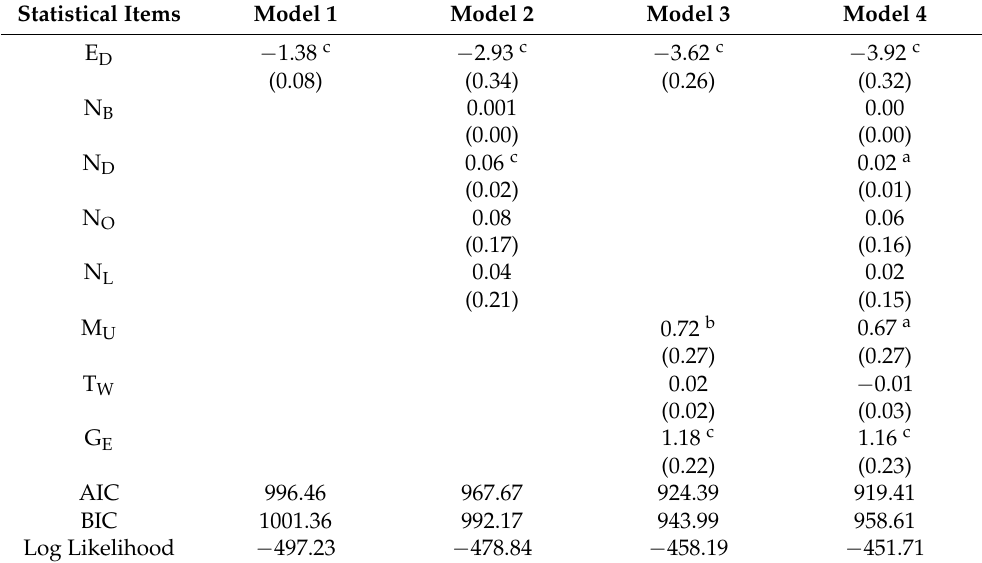
Table 6. ERGM estimation